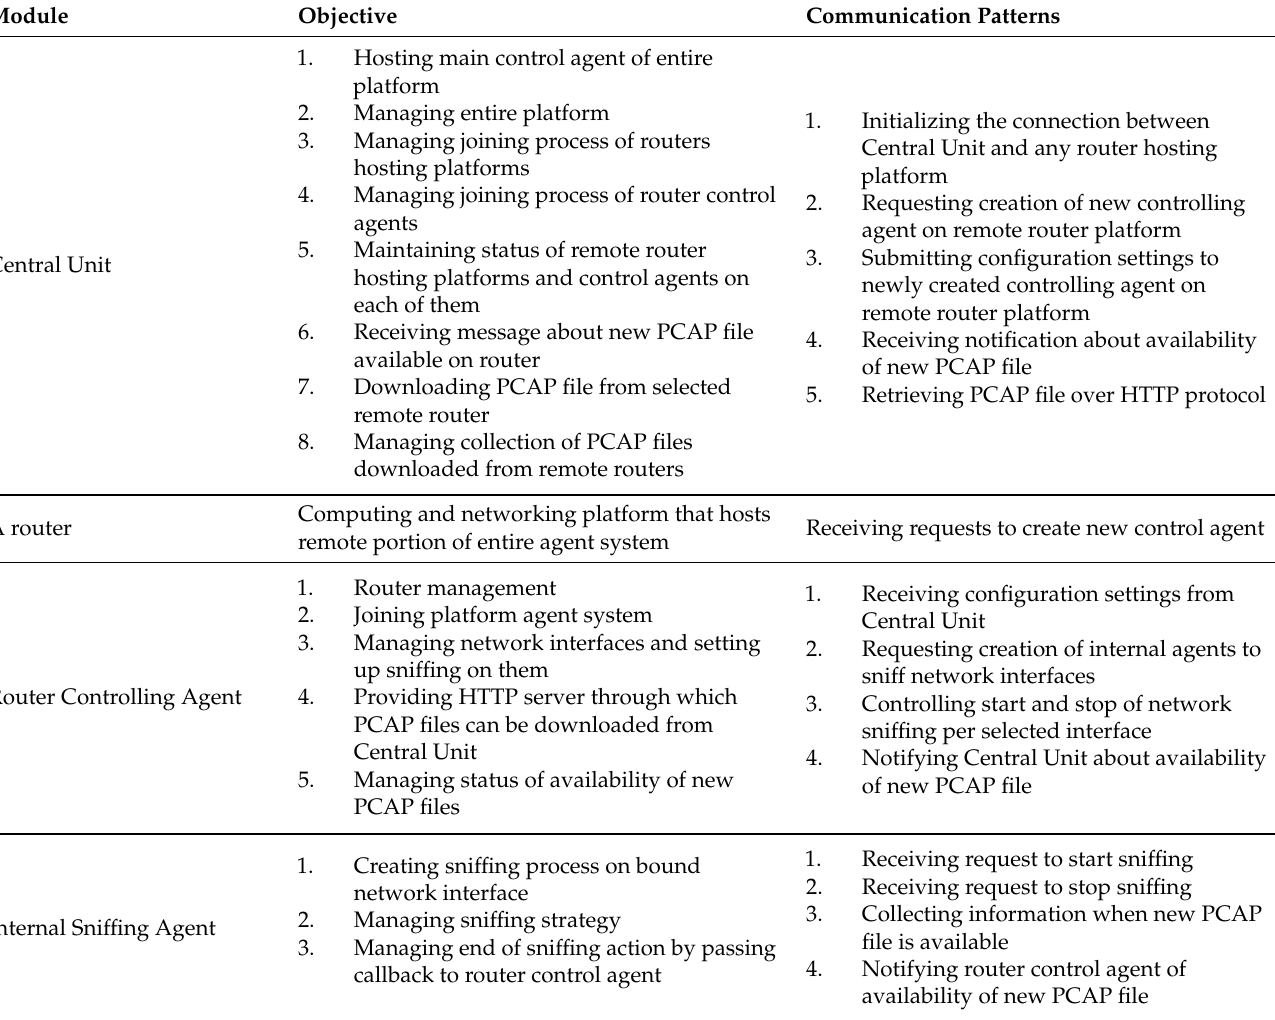
Table 1. Summary of operational aspects of multi-node Network Traffic Monitoring